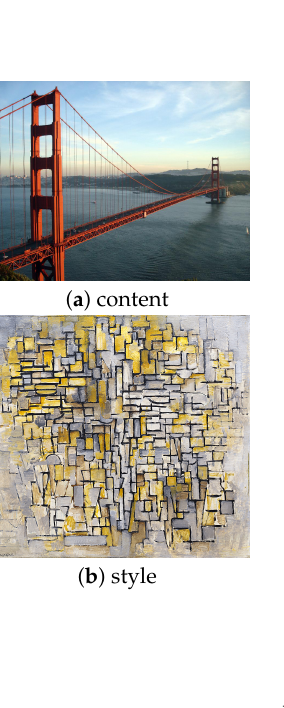
Figure 7. Results comparison for golden